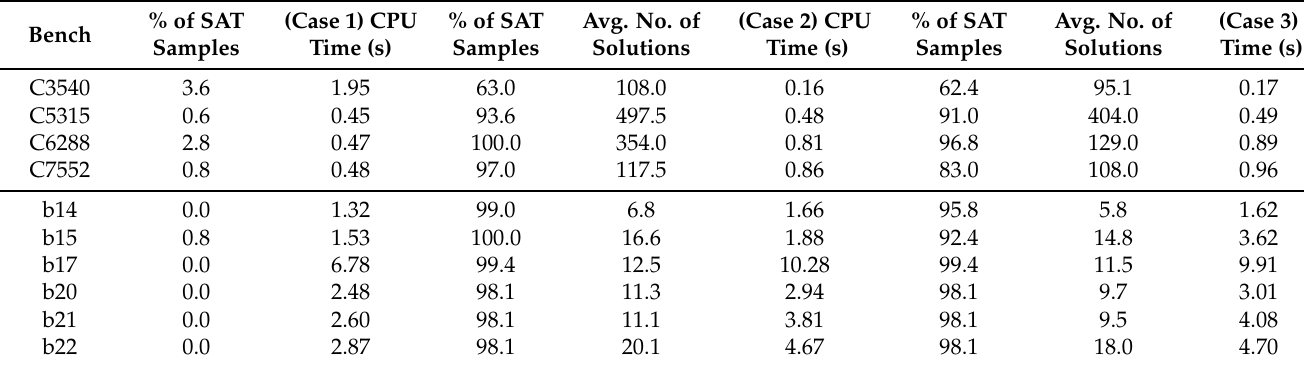
Table 3. Comparison between the model accounting for defects affecting fan-out stems (case 3) and models affecting cells with cardinality 1 (case 1) and 2 (case